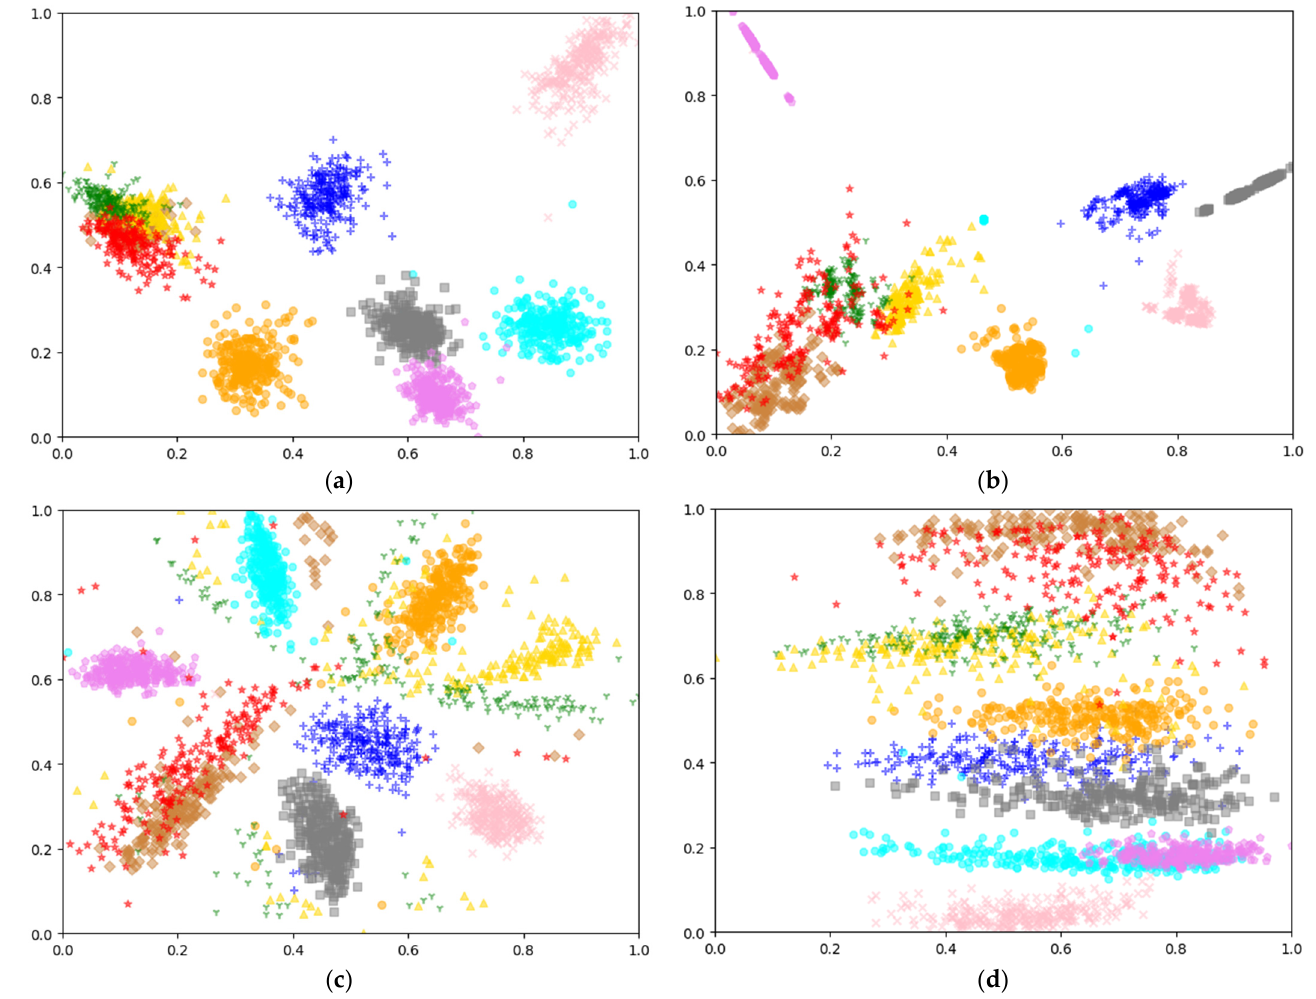
Figure 9. Visualizations of 2425 targets from the Testing Set in 10-type Dataset. ( a ) Visualization by LDA; ( b ) visualization by ISOMAP; ( c ) visualization by MDS; ( d ) visualization by TRTE. The horizontal and vertical axes represent the target feature in the two-dimensional space after the t-SNE dimensionality reduction in the high dimensional feature space.